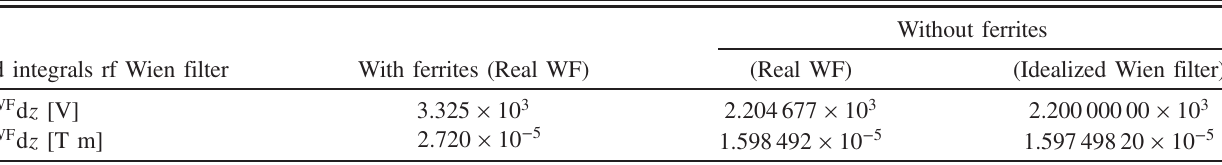
TABLE II. Values for the main electric and magnetic field integrals from the full wave simulation with and without ferrites for an input power of 1 kW where simulations. In this case, the unwanted field components vanish, i.e.,